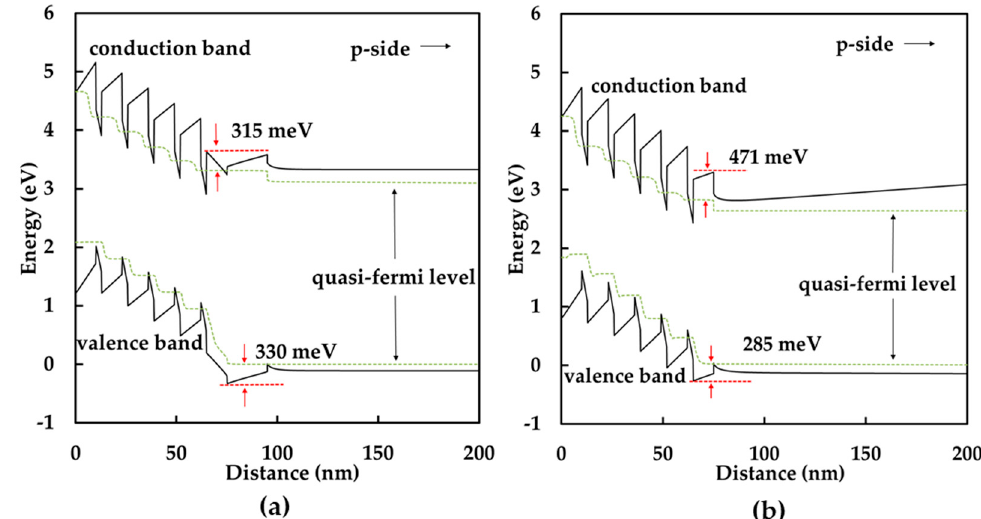
Figure 4. Calculated energy band diagrams at 300 mA of ( a ) sample A; and ( b ) sample B.